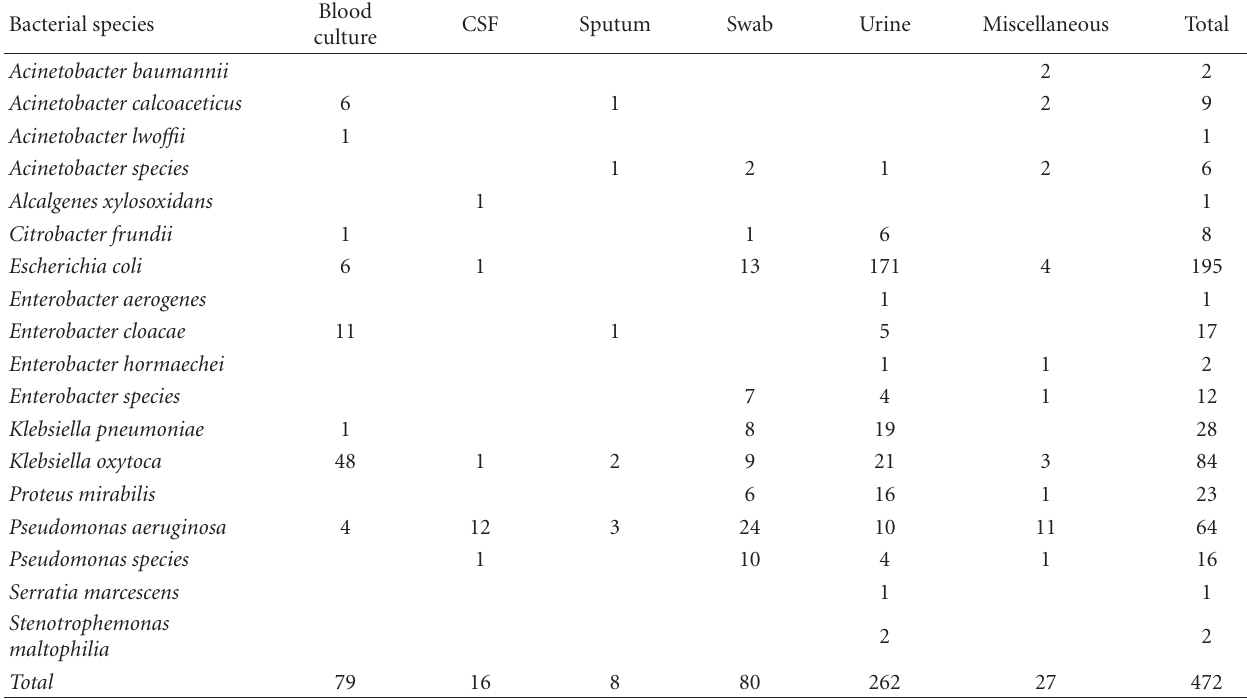
Table 1: Bacterial species isolated from clinical